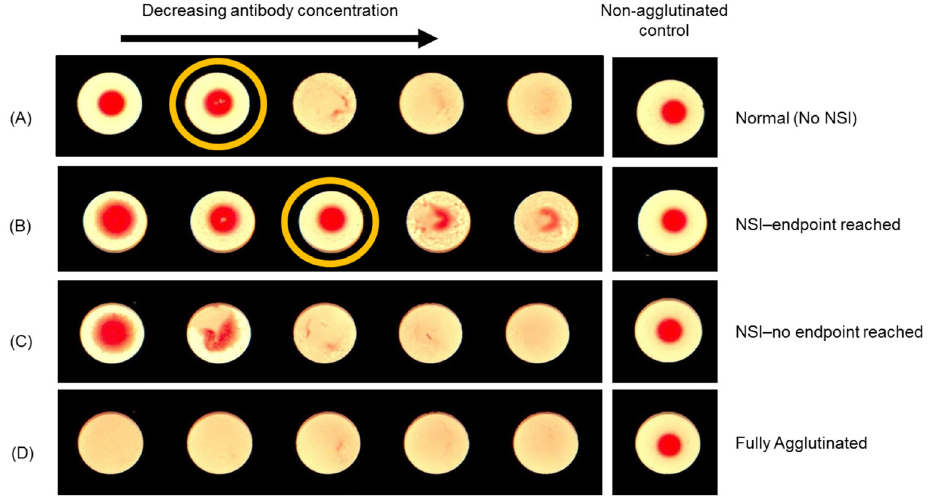
Fig 1. Morphological classifications within a sample titration. (A) HAI dilutionseries displayinga typical transition point in the absenceof non-specific inhibition;a direct comparisonof the first two wells to the negativecontrol in the far right well shows very similar size, shape and overall morphologyof the buttons. (B) HAI dilutionseries displayingnon-uniform morphologiesdue to non-specific inhibitionwithin the first well—an endpointis reachedin the third well; a direct comparisonof the third well to the negativecontrol in the far right well shows similar size, shapeand overall morphology. (C) HAI dilutionseries displayingnon-uniform morphologies due to non-specific inhibition; a direct comparisonof the negativecontrol in the far right well highlightsthe different morphology of the buttons as a function of dilution. (D) HAI dilutionseries displaying wells which are all fully agglutinated and have no inhibitionas comparedto the negativecontrol in the far right